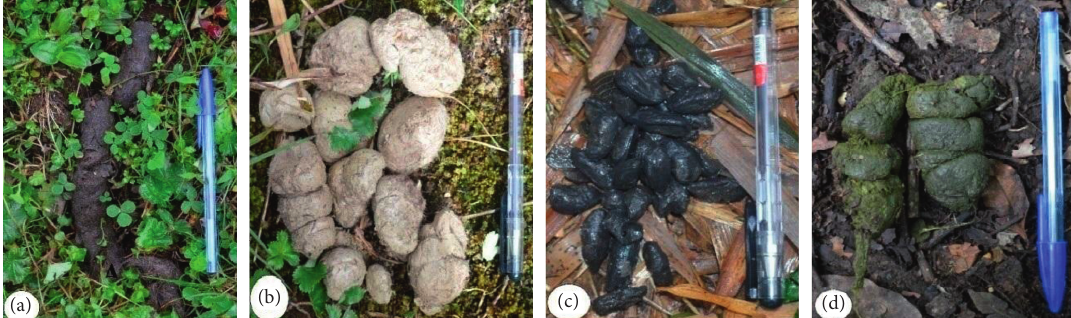
Figure 6: Scats of large mammals recorded at Arbegona, southern Ethiopia: (a) Panthera pardus ; (b) Crocuta crocuta ; (c) Hystrix cristata ; (d) Papio anubis (photo: Zerubabel Worku,